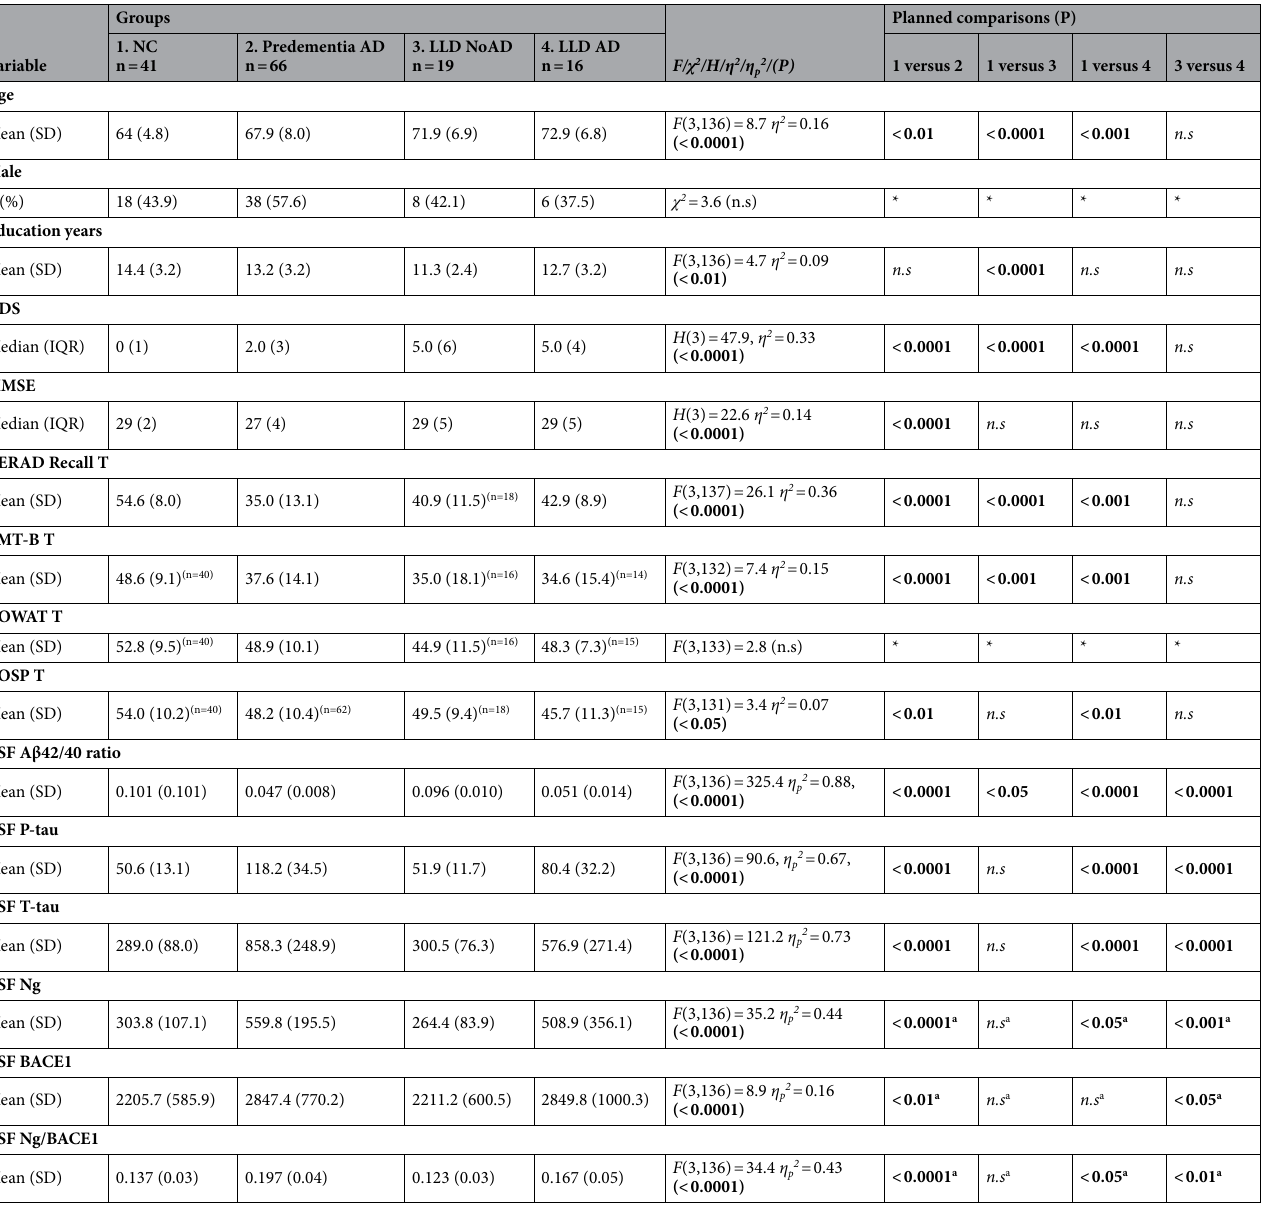
Table 3. Between-group comparisons of CSF biomarkers, demographics, clinical including neuropsychological data. n = sample size; n.s. = non-significant results; *no comparisons performed ; F = F-statistic; χ 2 = chi-square H = Kruskal–Wallis test; η 2 = eta-squared; η p2 = partial eta squared; P = p-value; IQR = interquartile range. a p values adjusted (p ADJ ) for familywise multiple testing according to Holm–